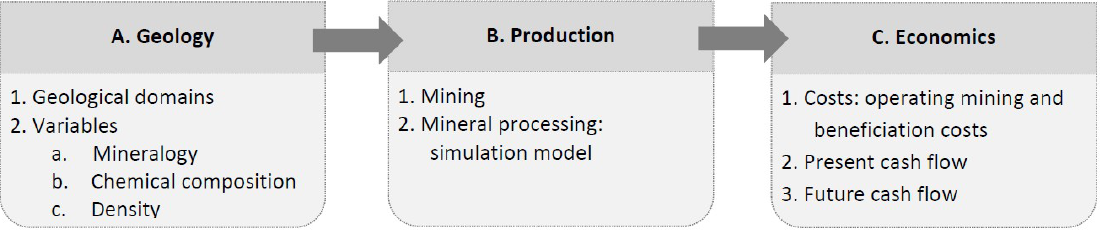
Figure 2. Structure of the deposit module of the synthetic ore body model.